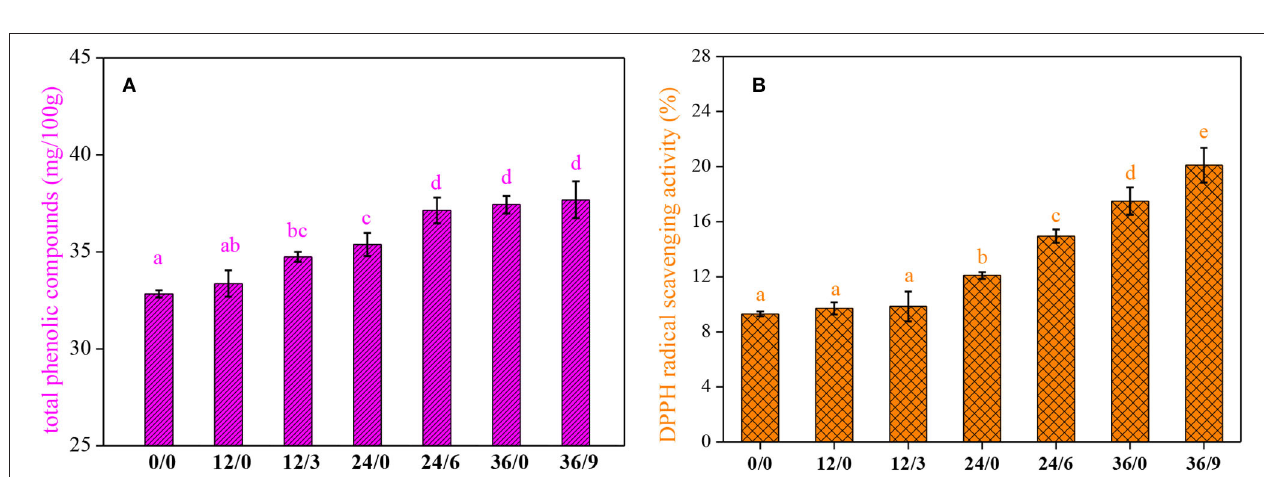
FIGURE 5 | The total phenolic compounds (A) and DPPH free radical scavenging capacity (B) of whole wheat flour during germination under UV-B radiation. Different letters indicate the results of Duncan’s multiple range test at 5% level of significant difference among different germination and UV-B radiation time,